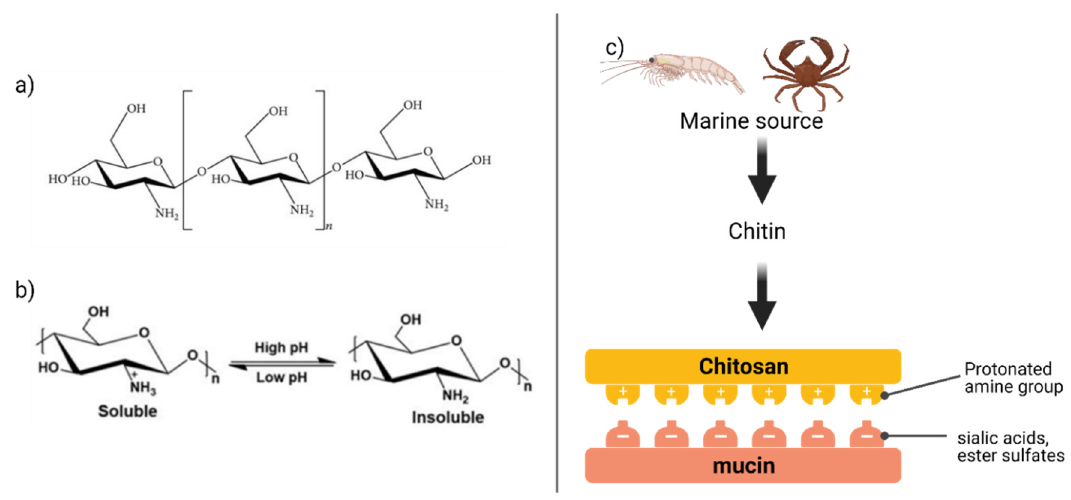
Figure 9. ( a ) chemical structure of chitosan molecule, ( b ) soluble characteristics, ( c ) production process of chitosan from marine source.